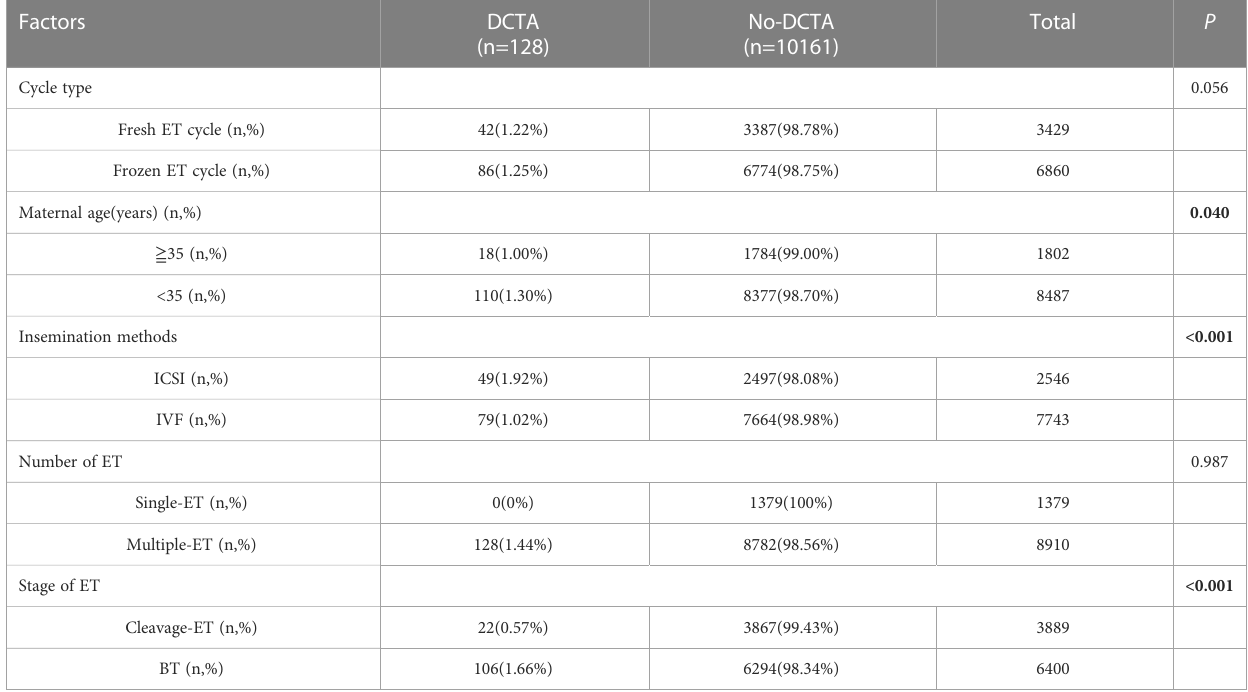
TABLE 1 Analysis of DCTA risk factors by multivariate logistic